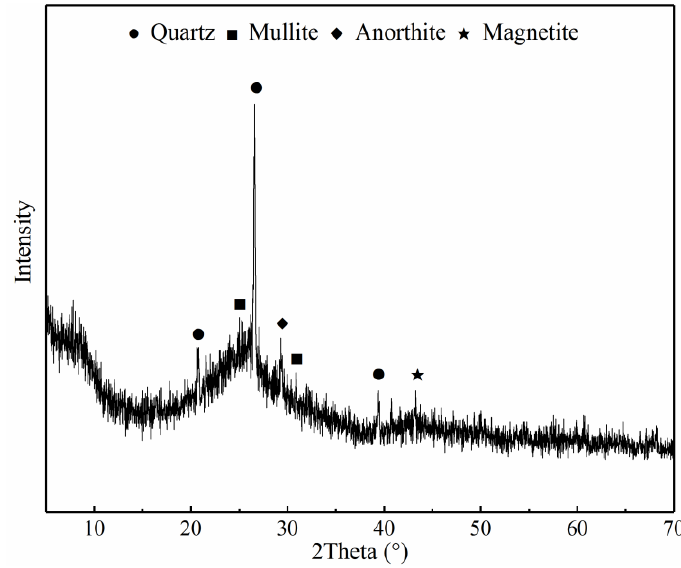
Figure 5. XRD pattern of MCS.